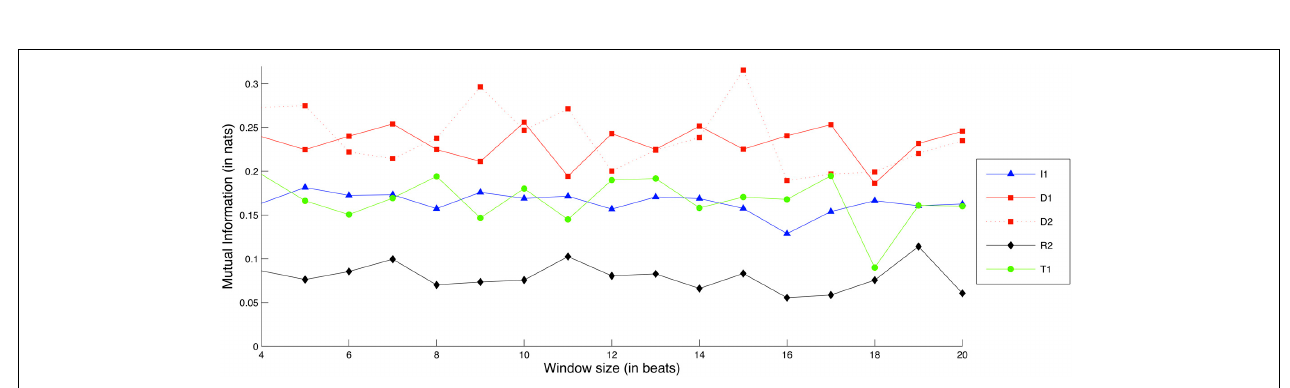
FIGURE 9 | Interdependence gain for the Intonation dimension, for different exercises and window sizes. (Legend: I1, Intonation exercise; D1, Dynamics exercise nr.1; D2, Dynamics exercise nr.2; R1, Rhythm exercise nr.1; R2, Rhythm exercise nr.2; T1, Timbre exercise).